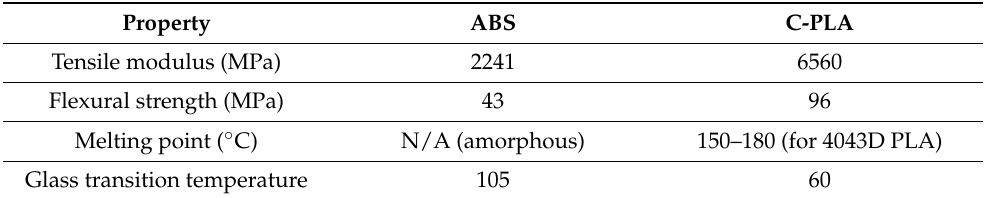
Table 1. Properties of ABS and C-PLA filaments.